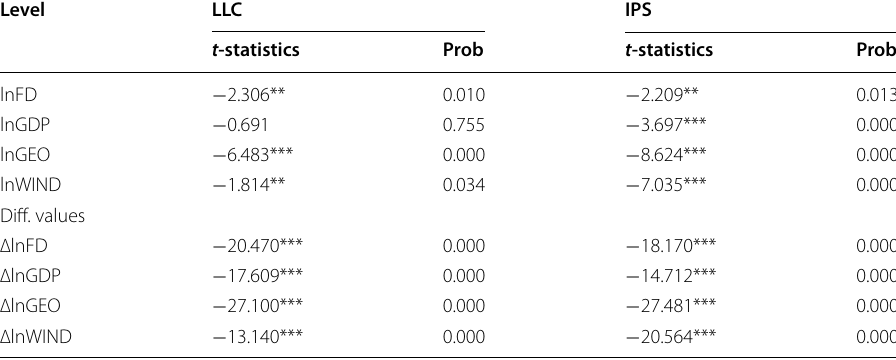
∆ indicates the first differences of the series. ***, **, and * indicate significance at 1%, 5%, and 10% significance levels,